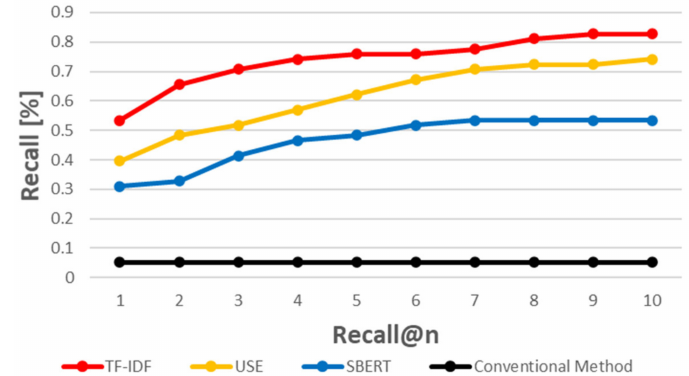
Figure 9. Recall for each